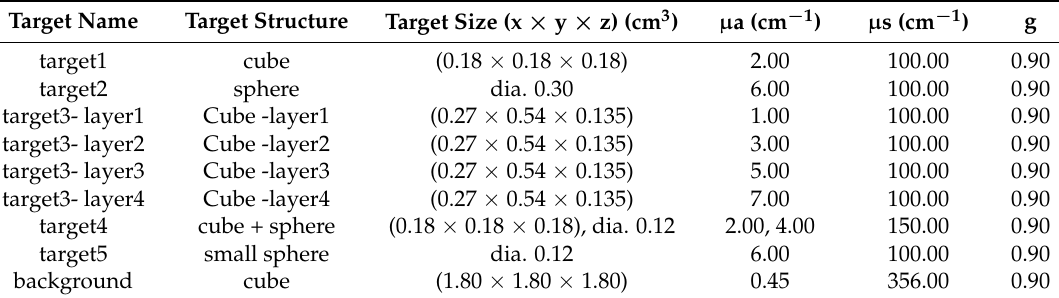
Table 1. Simulation